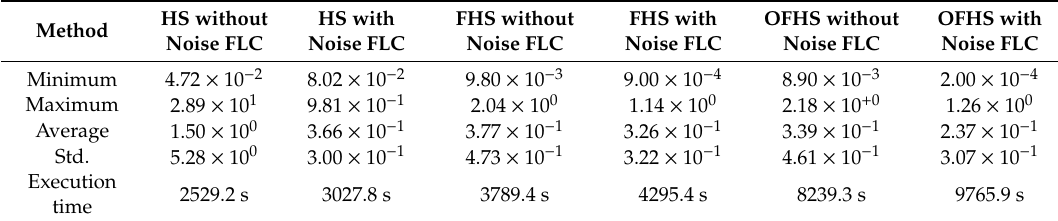
Table 16. Results of the OFHS method applied to benchmark